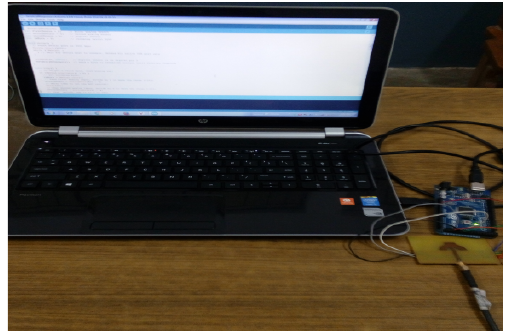
FIGURE 9. Fabricated antenna switching controlled by the microcontroller